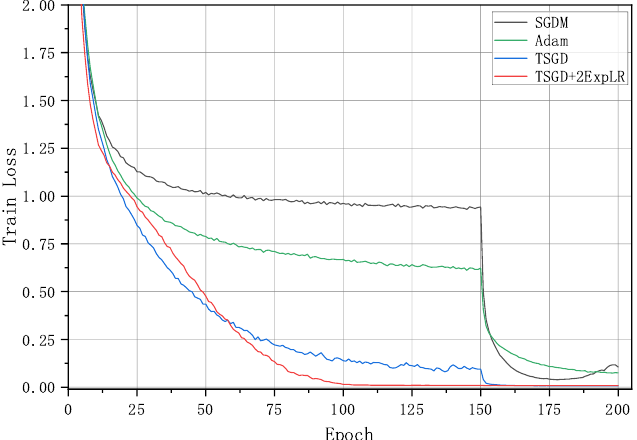
Figure 11. The loss of Cifar100-ResNet18 on the training